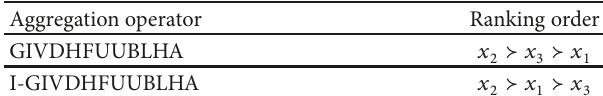
Table 5: Ranking results of operators GIVDHFUUBLHA and I-